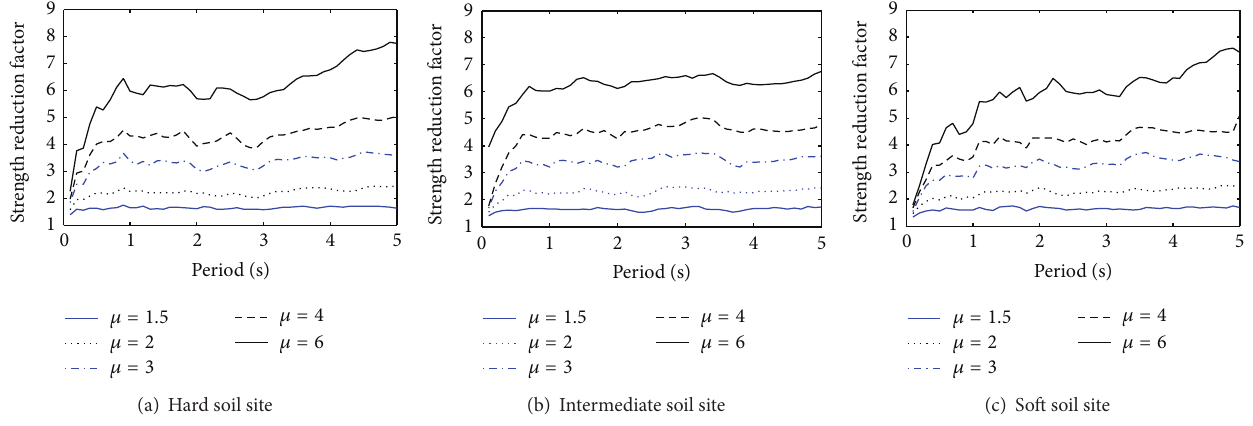
Figure 1: Strength reduction factor 𝑅 𝑠